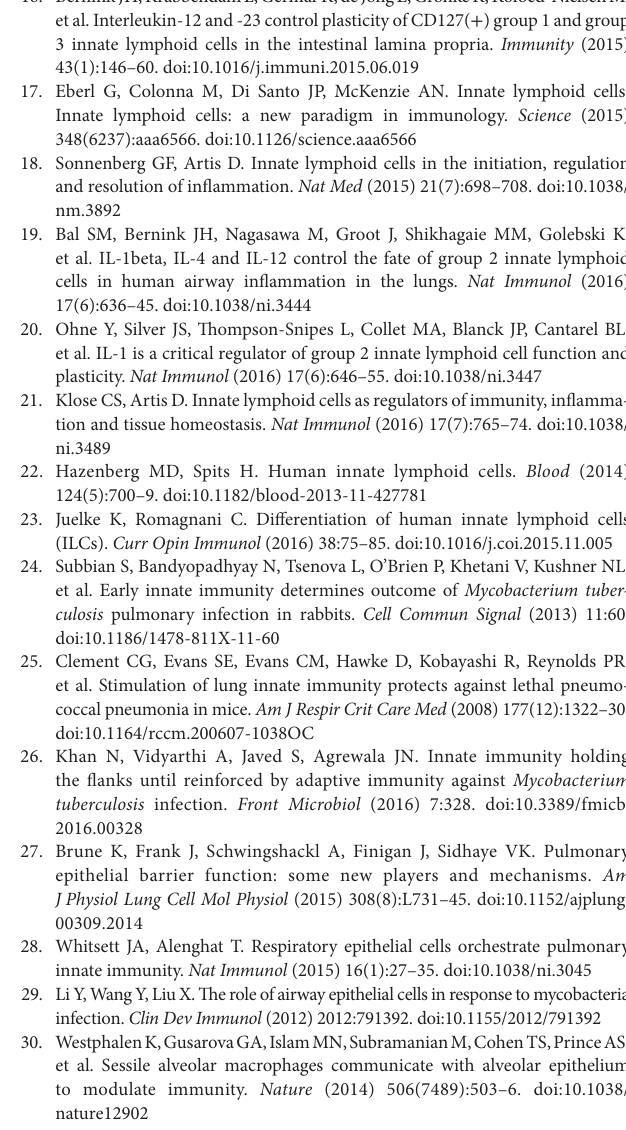
tissue sections. Cytokine levels are mean values from three individual tissue sections per donor with lines connecting values from uninfected and infected samples from each donor. FigUre s3 | (a) Gating strategy for innate tissue-resident cells, gated on lymphocytes in forward-side scatter. (B) Heatmap showing log2 fold changes of top differentially expressed genes for each donor and in all analyzed innate cells. Genes shown are unique transcripts from a combined list of the top 50 differentially expressed genes in each cell type. FigUre s4 | Expression and induction of proinflammatory chemokine genes upon Mycobacterium tuberculosis infection of human lung tissue. Plotted are log2 read counts per million sequenced reads from isolated cells for each donor tissue sample. Boxplots show median plus first and third quartile; whiskers extend to the most outer data point within 1.5 times the interquartile range. Each dot represents expression levels from an individual donor. FigUre s5 | High resolution version of Figure 3